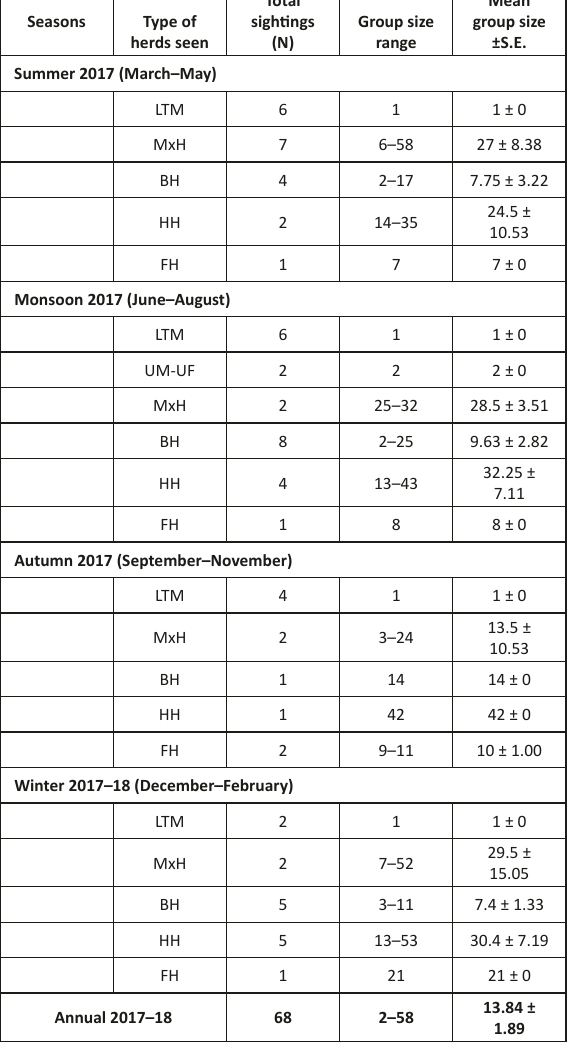
Table 4. Seasonal variations in the total sightings of Blackbuck, group size range and mean group size ± S.E. in Lalpur Jheel, Dobhi Village from March 2017 to February 2018. Type of herds